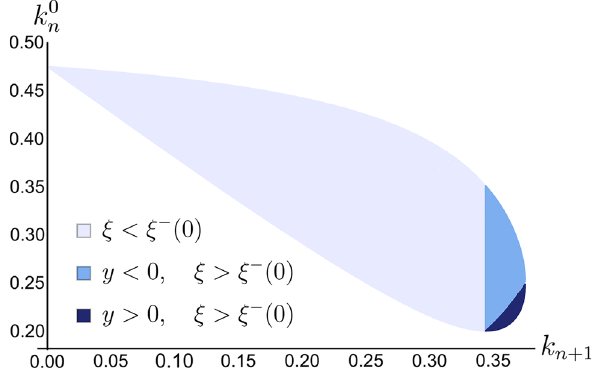
Fig. 4 Dalitz plot for the three-body phase space of the system com- prising the heavy flavour, the radiated gluon and the recoiling